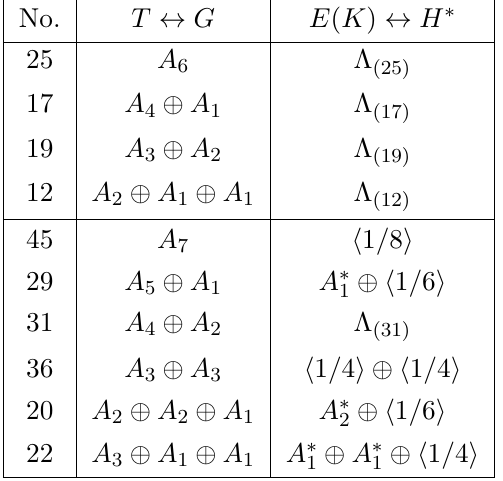
Table 1 . The non-Cartan type Mordell-Weil lattices E ( K ) that are torsion free and associated T are sublattices of A 7